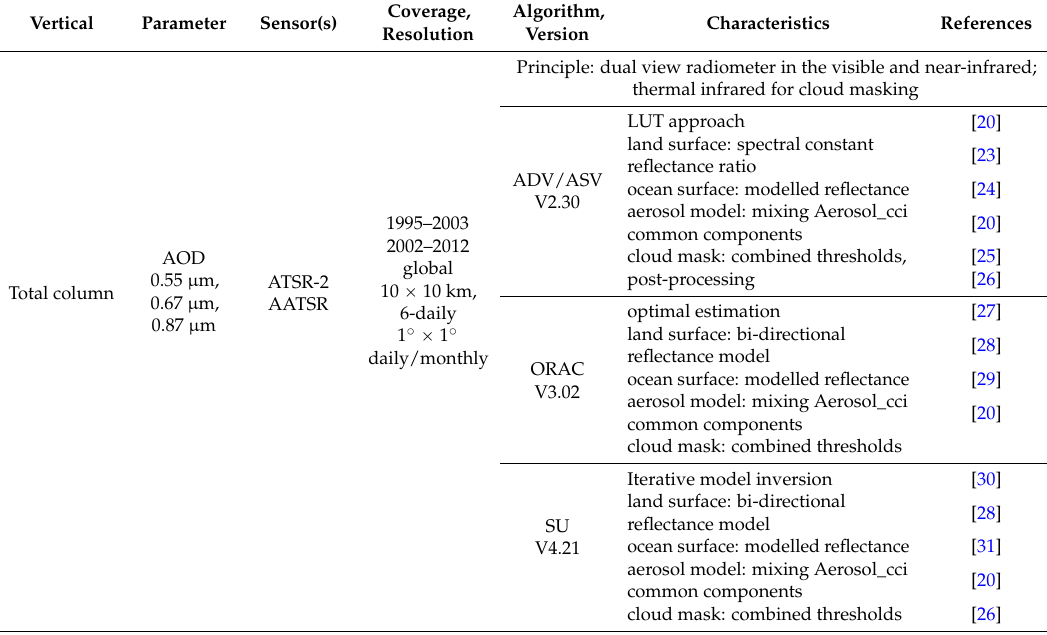
Table 1. Overview of ATSR (Along Track Scanning Radiometer) data records and algorithms discussed in this